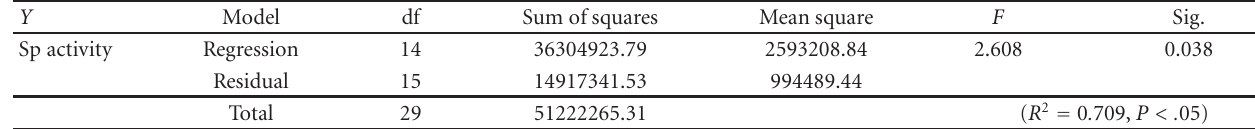
Table 4: Analysis of variance for the evaluation of the second-order model for the model.